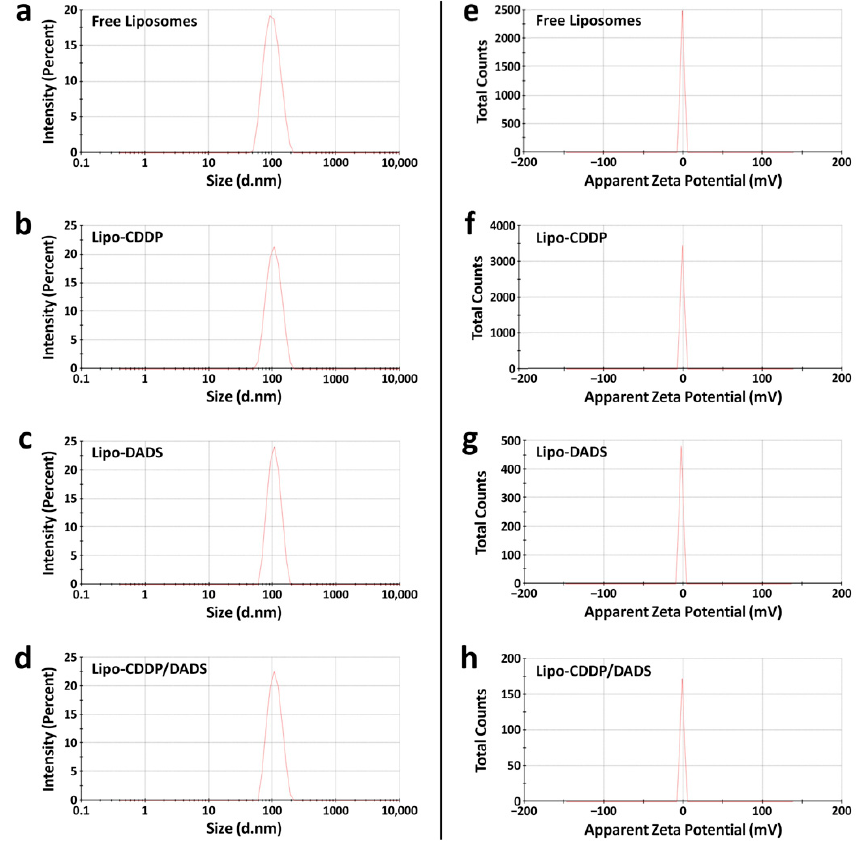
Figure 1. Size profiles of ( a ) free liposomes, ( b ) Lipo-CDDP, ( c ) Lipo-DADS, and ( d ) Lipo-CDDP/DADS and zeta potential profiles of ( e ) free liposomes, ( f ) Lipo-CDDP, ( g ) Lipo-DADS, and ( h ) Lipo-CDDP/DADS. The d.nm in ( a – d ) means diameter in nanometers, and the mV in ( e – h ) means millivolt.